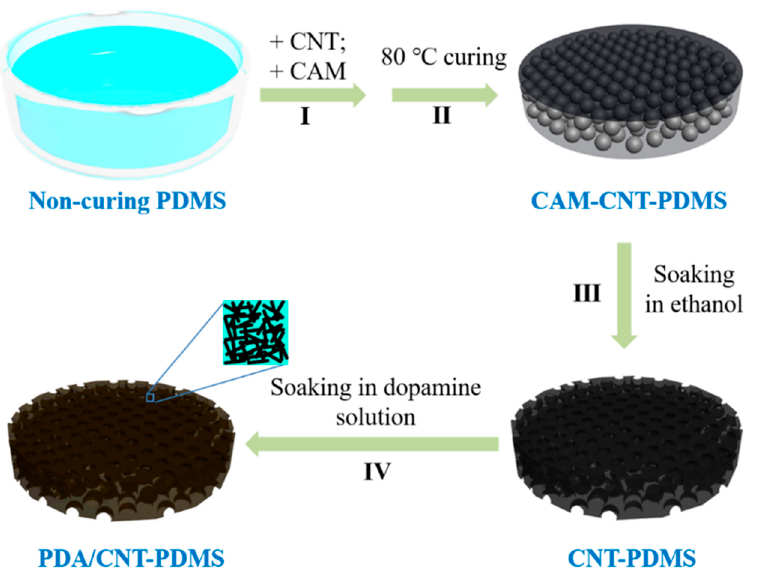
Figure 1. Schematic illustration of the preparation of CNT-PDMS and PDA/CNT-PDMS sponges.